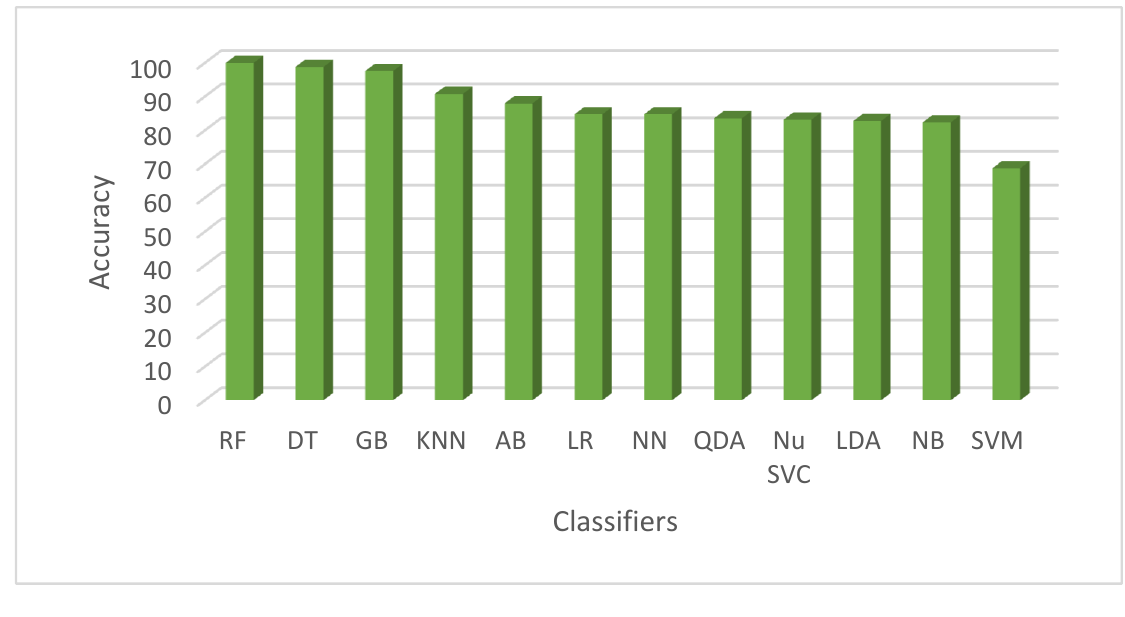
Figure 12. Classifiers Accuracy.